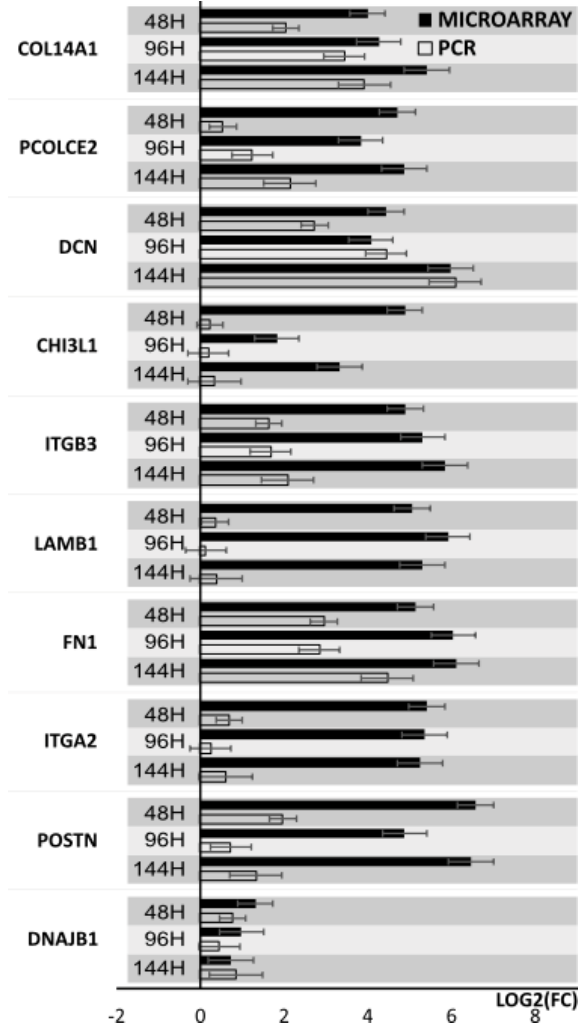
Figure 10. Bar graph showing validation results of microarrays of upregulated genes obtained by RT-qPCR.